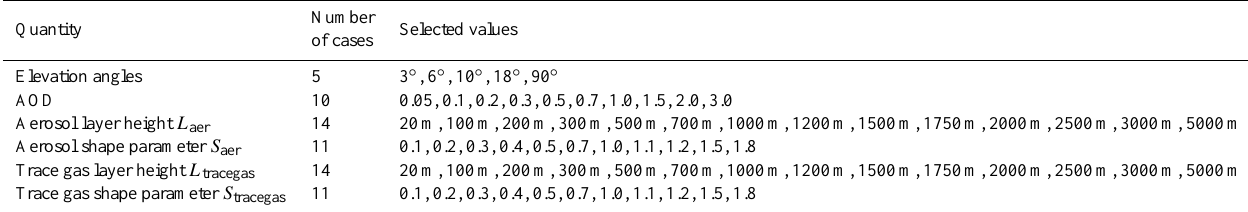
Table 2. Selected elevation angles and profile parameters, for which air mass factors for O 4 , HCHO, and NO 2 were calculated. O 4 dAMF α were calculated for all possible aerosol profiles. Trace gas dAMF α (NO 2 and HCHO) were calculated for all combinations of aerosol and trace gas profiles. For each case shown in Table 1, all combinations described in Table 2 were considered for the radiative transfer modelling. No clouds were included in the